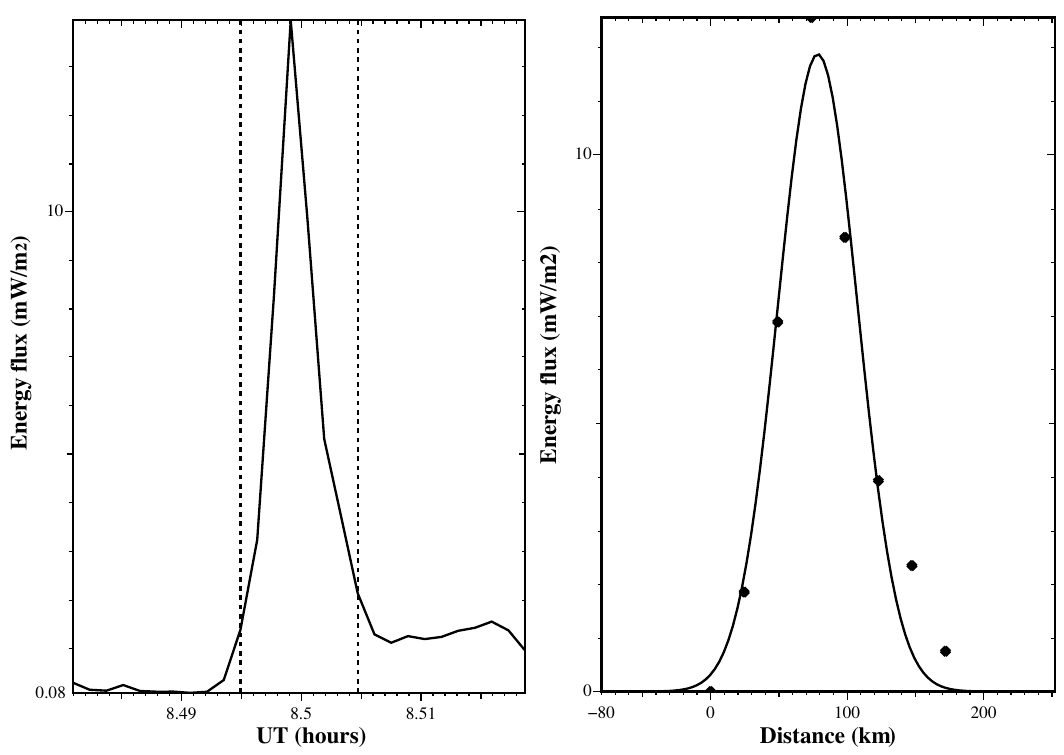
Fig. 11. An example of an energy flux peak within an inverted-V (left hand side) as well as the fitted Gaussian curve to the energy flux (right hand side). The diamonds represent the data points and the vertical lines mark the start and end times of the event corresponding to the first and last pink spots in Figure 1.